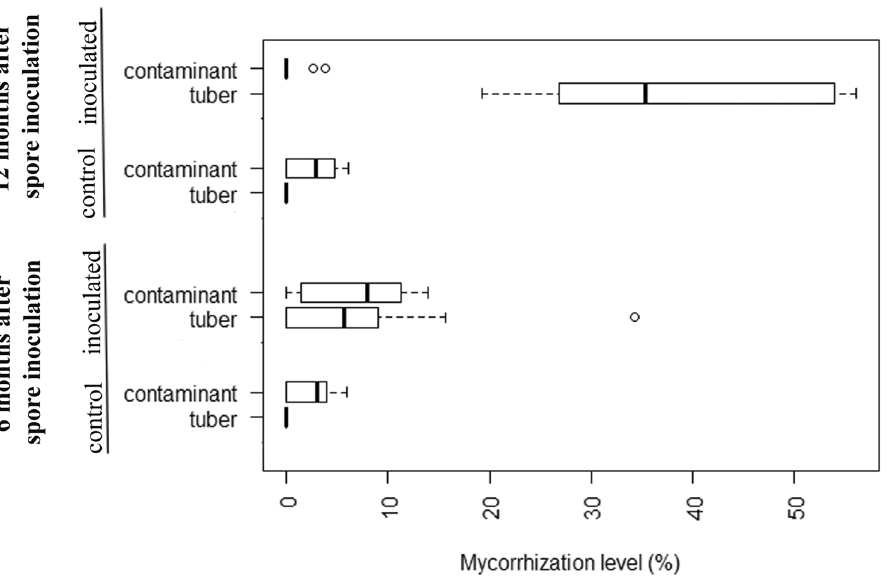
Figure 2. Mycorrhization levels (%) of silver fir plants inoculated with Tuber aestivum and control plants, 6 and 12 months after the start of the experiment. The figure represents a boxplot based on % of mycorrhized fine roots based on ten seedlings per treatment. Outliers are shown with circles.